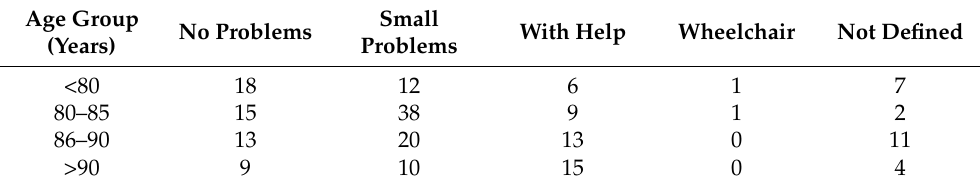
Table 5. The distribution of mobility status for different age